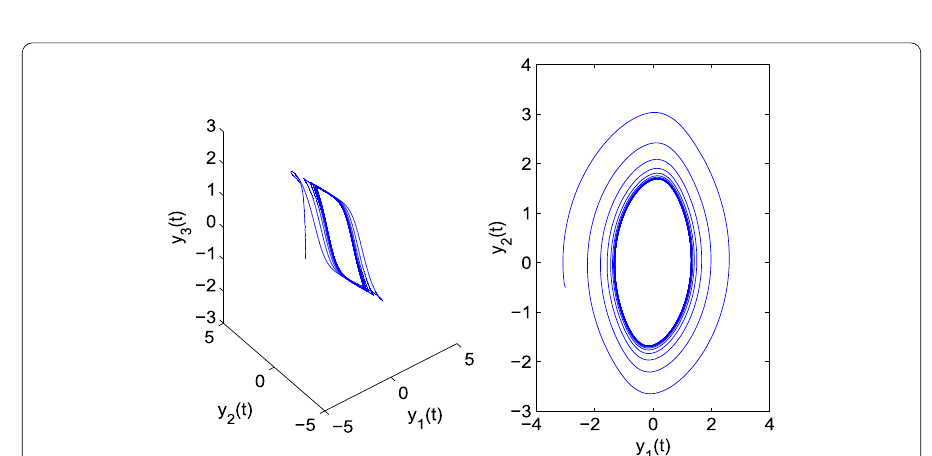
Figure 5 The fractional-order slave system in Example